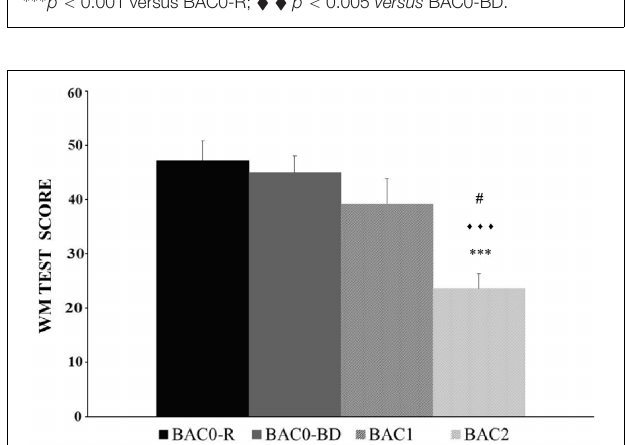
FIGURE 3 | Performance of the Working Memory task (Mean ± SEM) by male and female adolescents with different BACs (BAC0-R: 0 g/L, in refrainers;